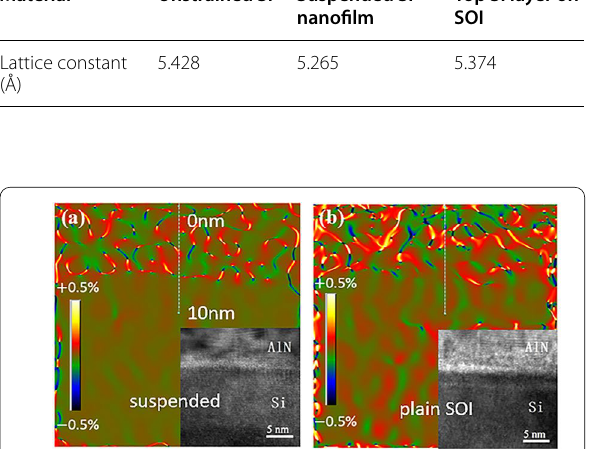
Top Si layer on nanofilm SOI